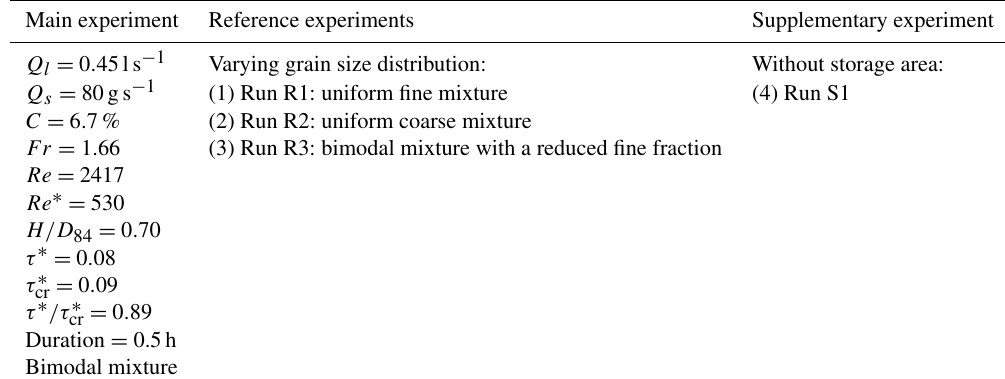
Figure 4. Grain size distribution of the different sediment mixtures used in the experiments. Table 1. Experimental conditions.